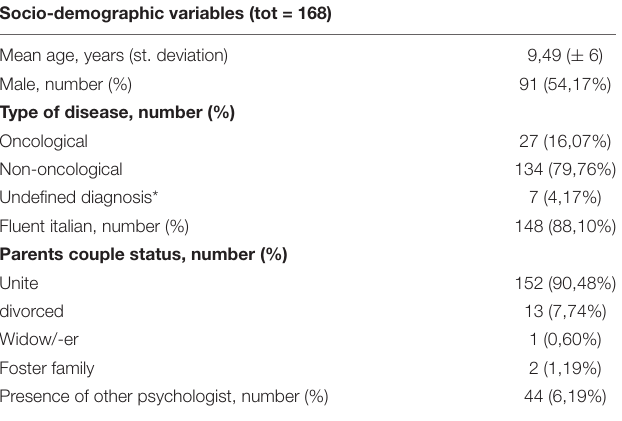
TABLE 1 | Socio-demographic